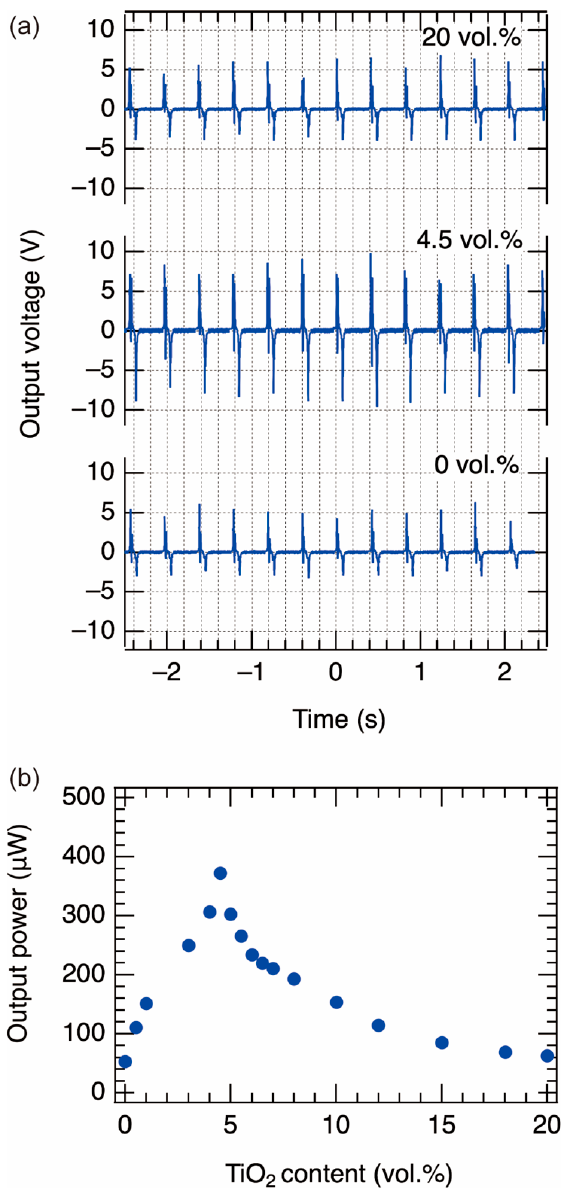
Figure 3. ( a ) The power generation waveform of the composite film shown on the oscilloscope. ( b ) The relationship between the content of TiO 2 NPs and the output power.